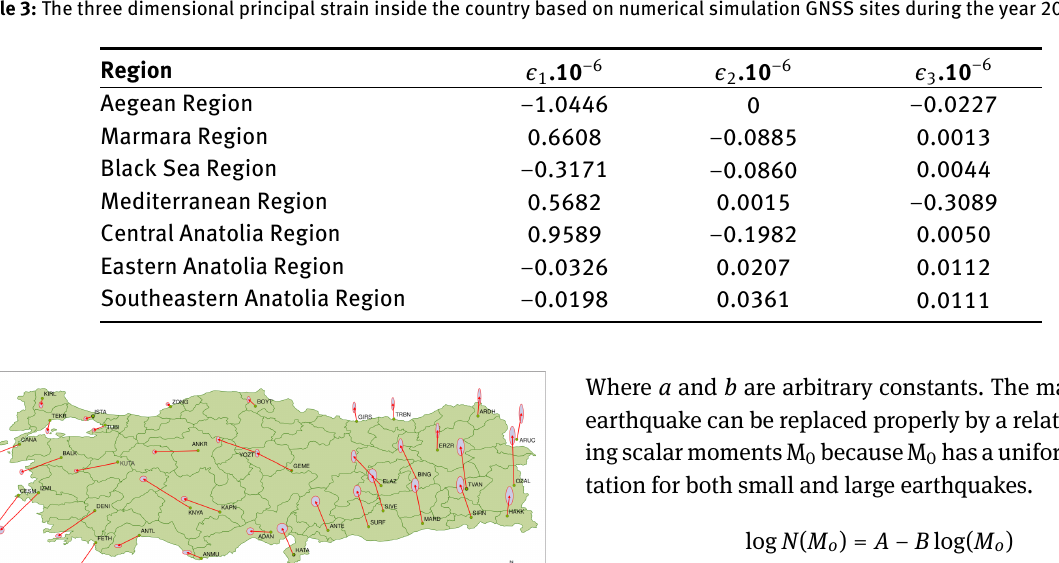
Figure 4: The changes in baseline length relative to an arbitrary zero-offset for the period 2009 to 2017 Table 3: The three dimensional principal strain inside the country based on numerical simulation GNSS sites during the year 2009 to 2017